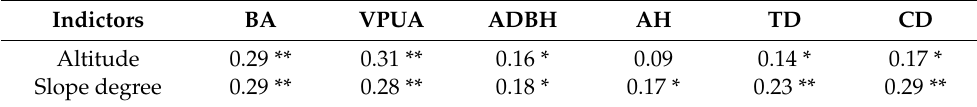
Table 12. Relationships between forest structure and altitude and slope degree respectively. Indictors BA VPUA ADBH AH TD CD Altitude 0.29 ** 0.31 ** 0.16 * 0.09 0.14 * 0.17 * Slope degree 0.29 ** 0.28 ** 0.18 * 0.17 * 0.23 ** 0.29